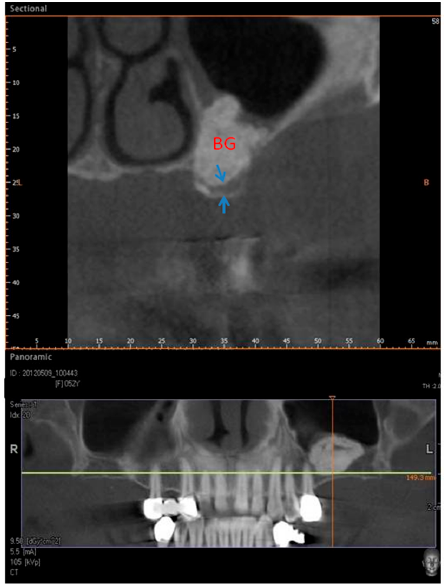
Figure 3. Group I. Six months after sinus lifting. CBCT image showing reduced bone height in the sinus area with a residual alveolar ridge height between 1 and 3 mm (arrows) and bone graft (BG). Newly formed bone with wide osteocyte lacunae and large marrow spaces were present with newly formed vessels and no inflammatory cell infiltrate (Figure 4). In a few areas, it was possible to see a rim of osteoblasts, while no osteoclasts or macrophages cells were present. No resorption evidence was present in the sample. In a few areas, it was possible to observe the presence of compact, mature cortical bone, which could be easily differentiated from the newly formed bone. The tissues present in the sample were composed of 34 ± 1% new bone, 38 ± 3% marrow space, 35 ± 4% residual biomaterials and 3.02 ± 2% osteoid tissue.